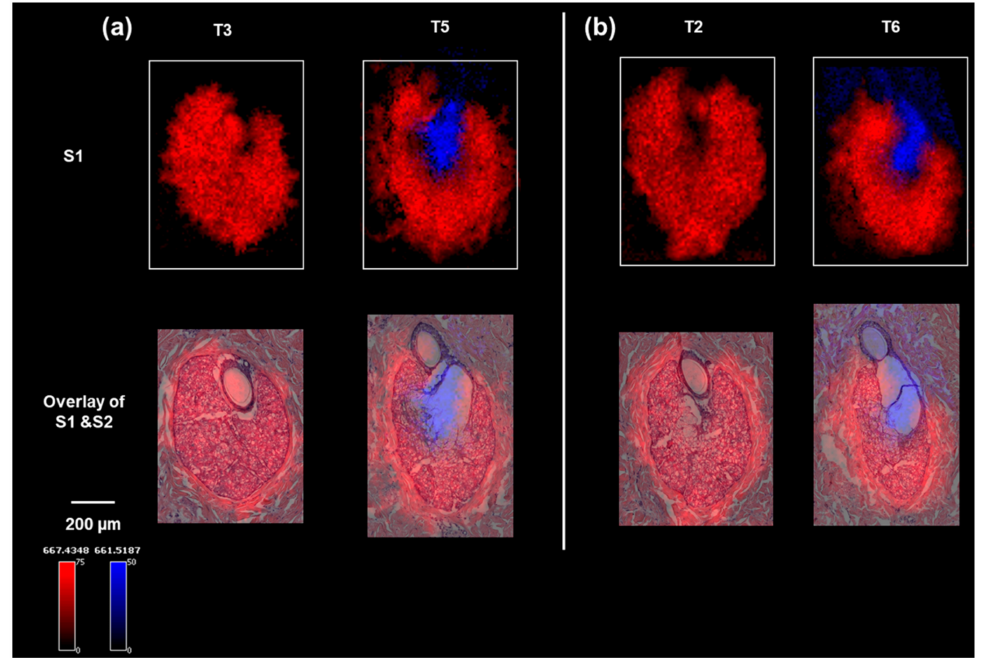
Figure 2. Ion images of sebaceous glands on minipig skin sections: ( a ) ion images of m / z 667.4348 (a peripheral zone marker) and m / z 661.5175 (a central zone marker) on the sebaceous glands of S1T3 and S1T5, and overlaid with H&E staining of the sebaceous glands on section S2T3 and S2T5; ( b ) ion images of m / z 667.4348 (a peripheral zone marker) and m / z 661.5187 (a central zone marker) on the serial sections of S1T2 and S1T6, and overlaid with H&E staining of the sebaceous glands on section S2T2 and